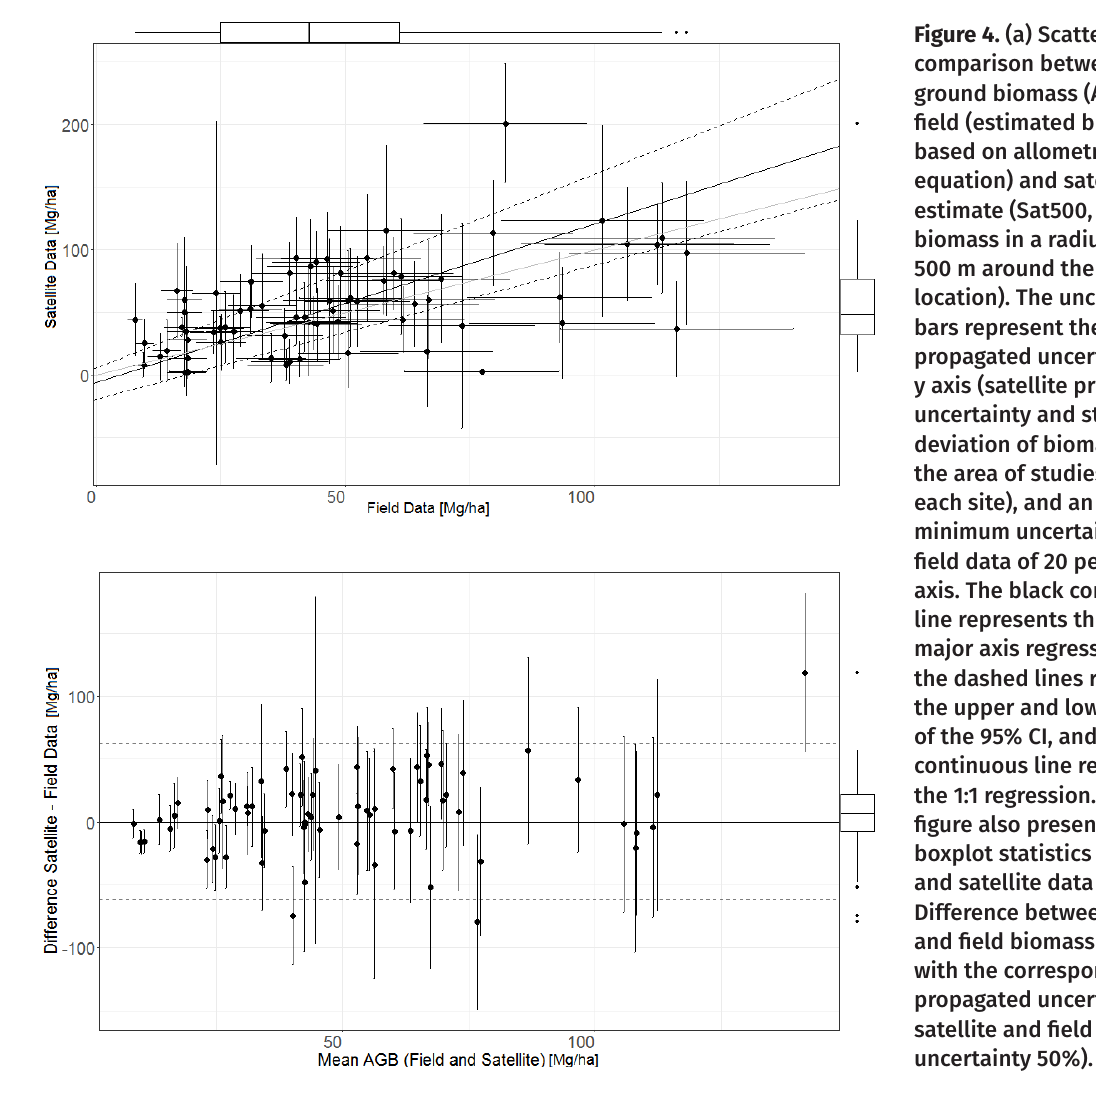
(r=0.9, statistic correlation significance of 0.015)